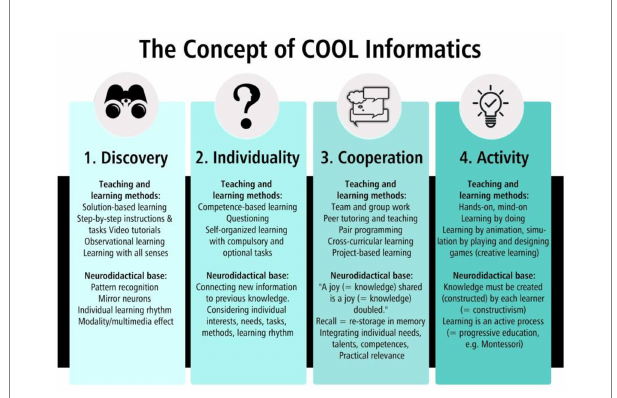
FIGURE 2 The four pillars of the core concept of COOL Informatics (Sabitzer, 2013).